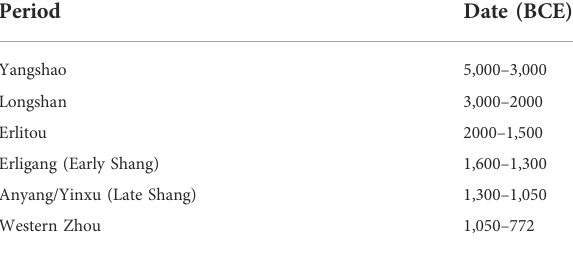
TABLE 1 Chronology of Northern China associated with this study.